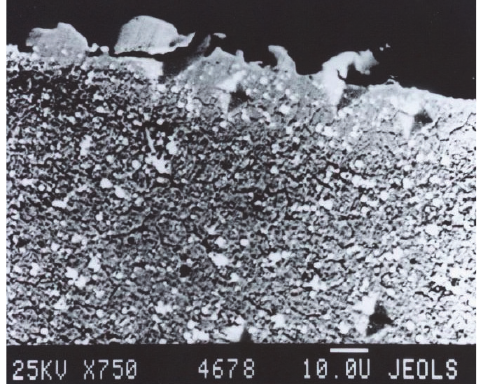
Figure 4: SEM micrograph of modified HS 6-5-2 steel surface at 100 V, 2